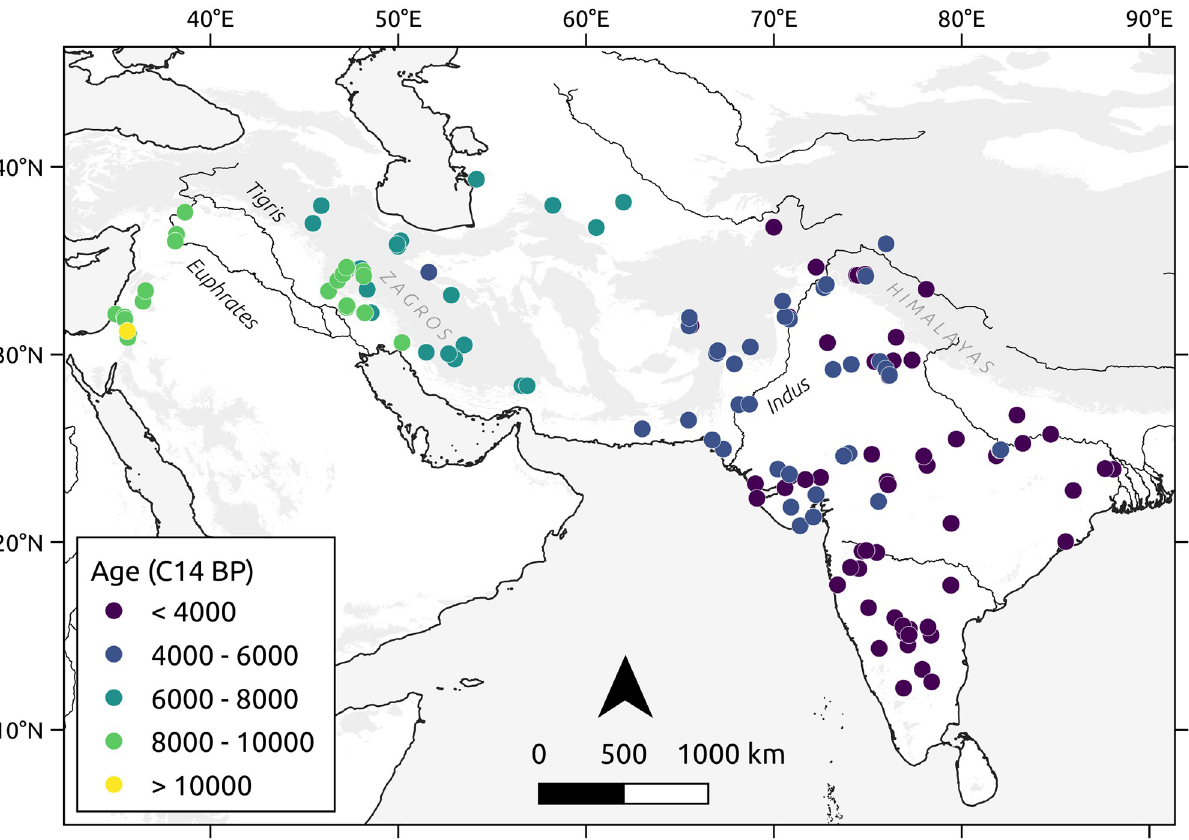
Fig 1. Dated sites related to the spread of the southwest Asian agricultural package selected for this study. Grey areas represent elevated regions with > 1000 masl.